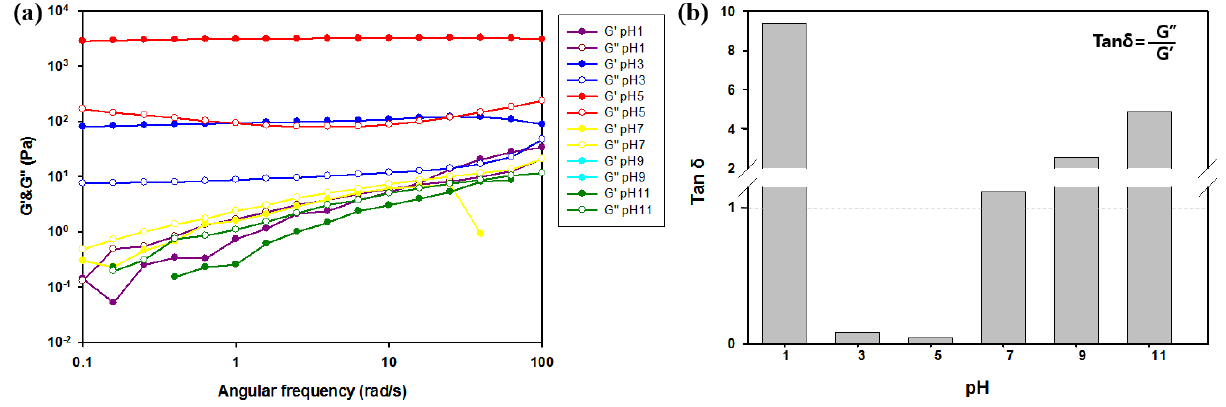
Figure 10. pH-Dependent gelation effect and mechanical properties of SC 26.4 . ( a ) Storage modulus (G′, filled symbols) and loss modulus (G″, empty symbols) of hydrogels. ( b ) Loss tangent (tan δ) of hydrogels.